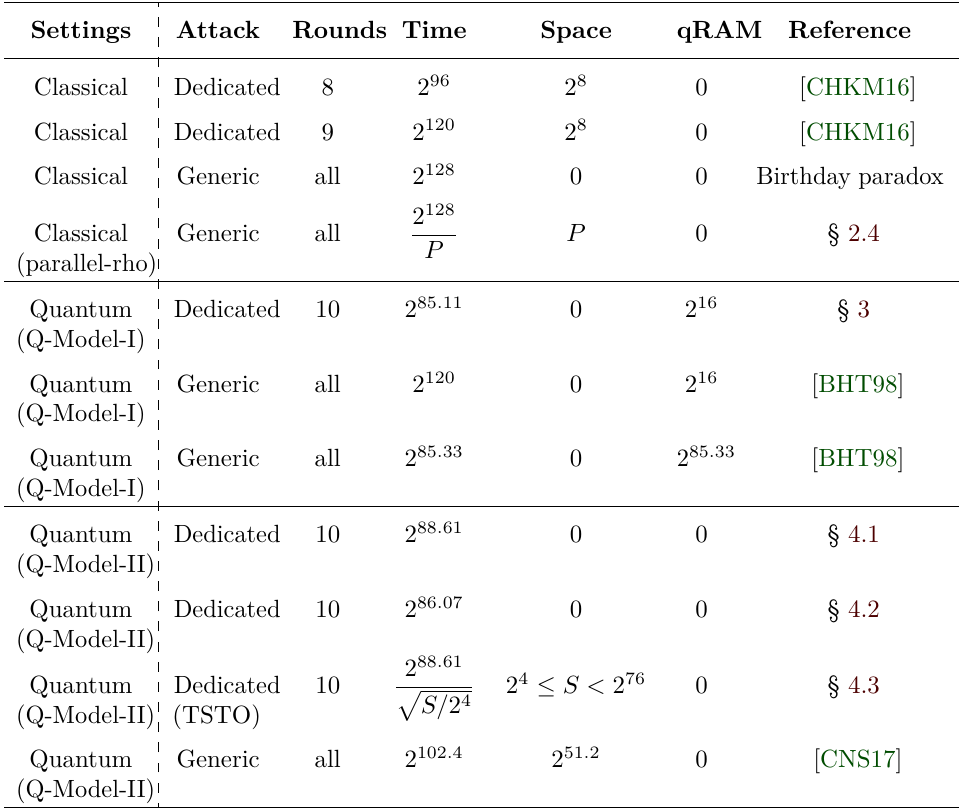
Table 1: Classical and quantum free-start collision attacks on HCF-AES-256 . Q-Model-I and Q-Model-II denote quantum-attack settings with qRAM and without qRAM, respectively. P denotes the number of classical processors. S denotes the size of quantum computer in qubits. TSTO denotes the time-space trade-off